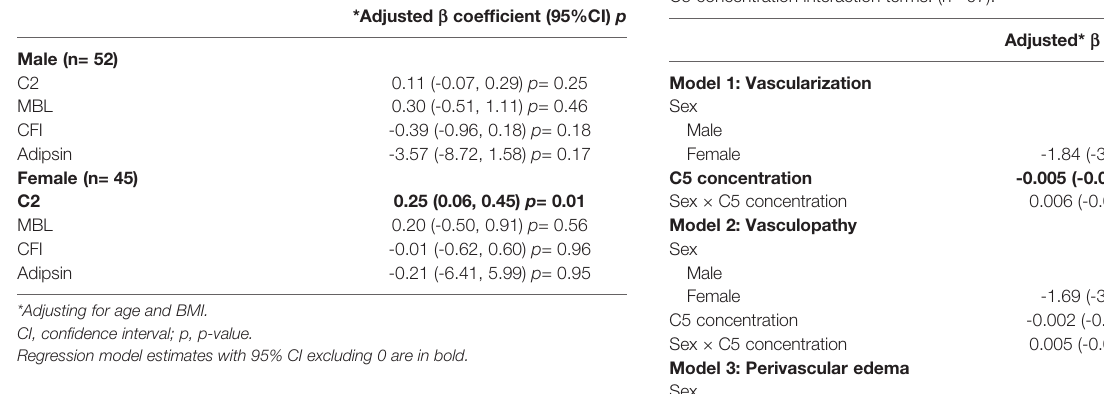
TABLE 5 | Multivariate linear regression model estimates for the association between vascular pathology and C5 synovial fl uid concentration, including sex by C5 concentration interaction terms. (n= 97).